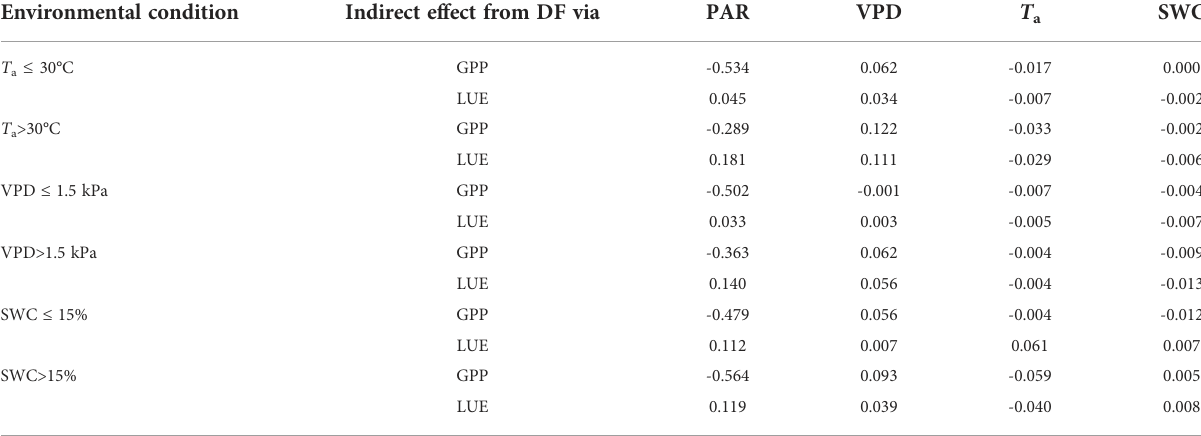
TABLE 4 The indirect effect from diffuse fraction (DF) through other environmental factors to gross primary productivity (GPP) and light use ef fi ciency (LUE). Environmental